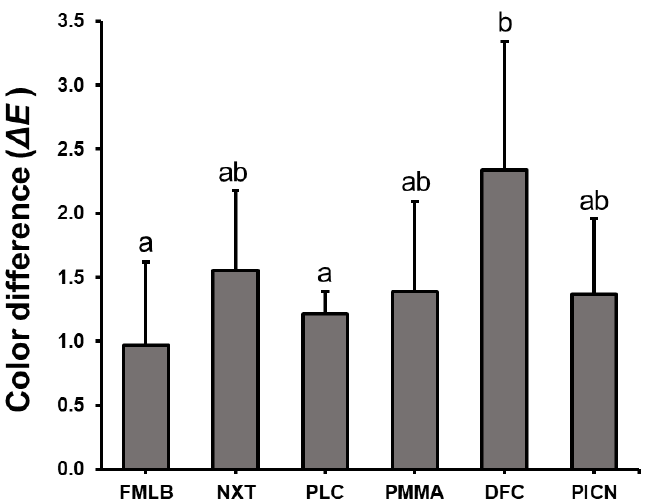
Figure 6. Color differences of six materials after artificial toothbrushing. Significant differences in color change between materials are indicated by different lower-case letters ( p < 0.05).